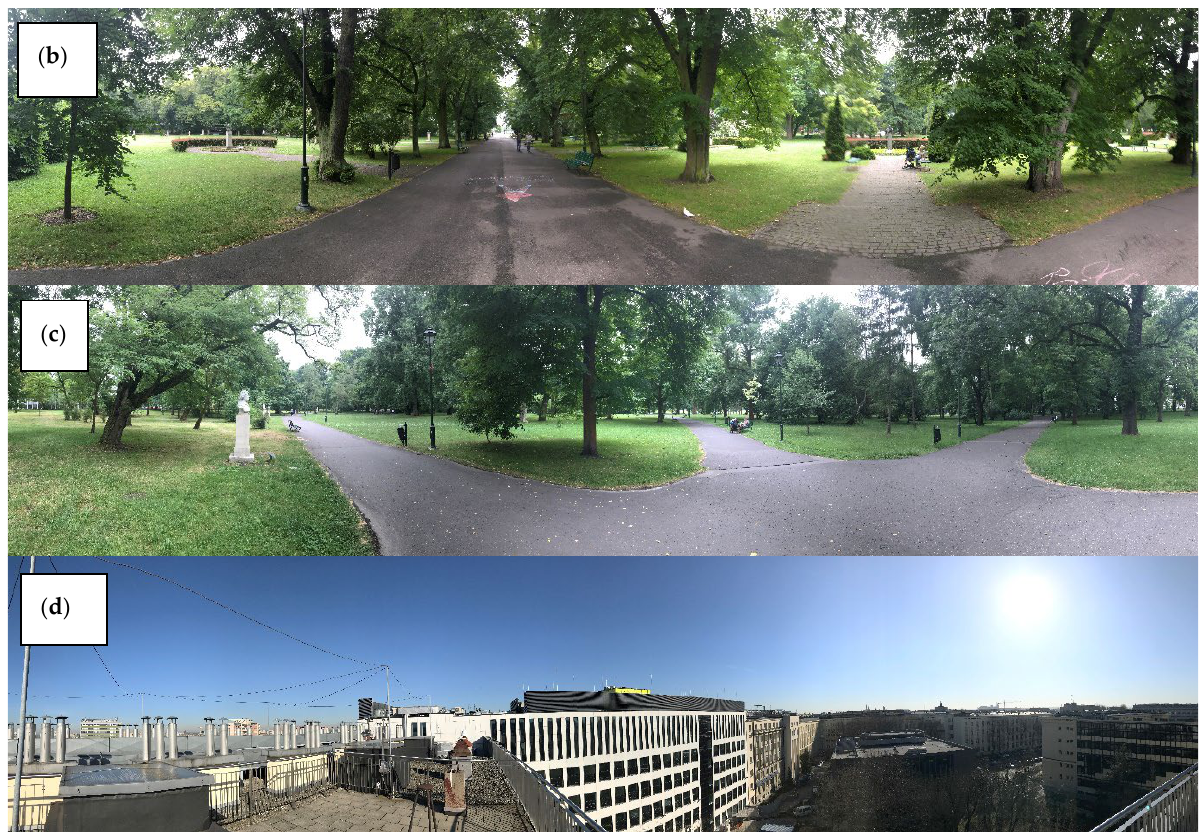
Figure 4. Panorama of objects: ( a ) surface, ( b ) line, ( c ) point, ( d ) static session.